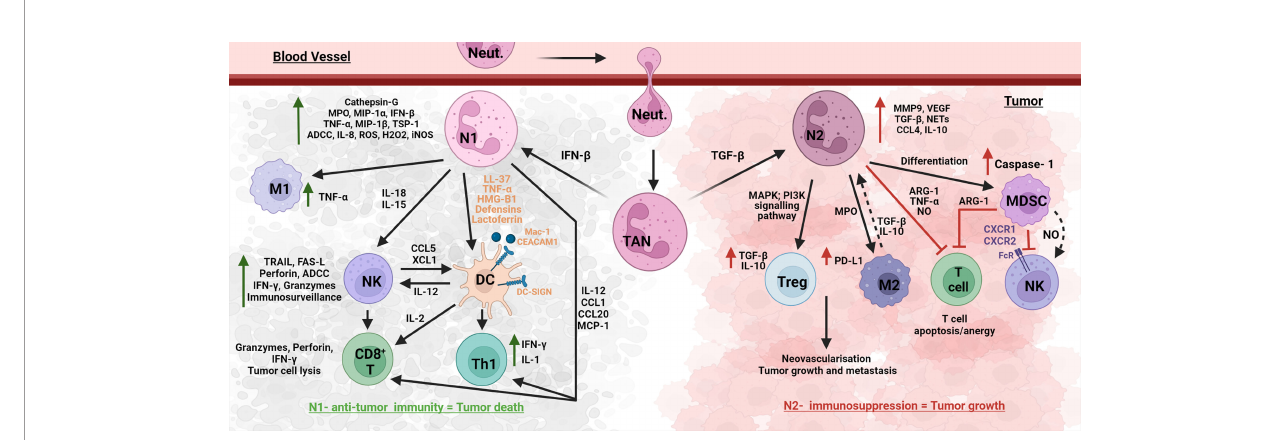
FIGURE 5 | Neutrophil networks affecting oral cancer outcomes. Neutrophils interact with anti-tumor and suppressive immune cells in the complex TME ecosystem. TME recruited neutrophils, TANs (tumor-associated neutrophils) polarize to a N1 anti-tumor phenotype in the presence of IFN- b , and to a N2 tumorigenic phenotype with TGF- b . N1 neutrophils upregulate several molecules such as cathepsin-G, MPO, MIP-1 a / b , IFN- b , TNF- a , IL-8, and TSP-1, to induce other immune cells and also execute N1 functions such as ADCC, ROS, and iNOS-induced cytotoxicity. N1 induce M1 TAM, NK (IL-18, 1L-15), T cells (IL-12, CCL1, CCL20, MCP-1) and DCs (LL-37, TNF- a , HMG-B1, defensins, lactoferrin, cell interaction Mac-1/CEACAM1 – DC-SIGN). DCs further aid in N1 induced NK via IL-12, and NK aid in N1 induced DC via CCL5 and XCL1. N1 induced DCs further promote CD8 + T cells and Th1 cells. Interaction of these anti-tumor immune cells with N1 promotes tumor death. On the other hand, N2 neutrophils promote suppressive cells such as MDSC, Treg, and M2 and function via molecules such as MMP-9, VEGF, TGF- b , NETs, CLL4, and IL- 10. N2 and MDSC inhibit anti-tumor T cells via Arg-1, TNF- a , and NO; and NK cells via NO and CXCR1/2. These lead to tumor growth and